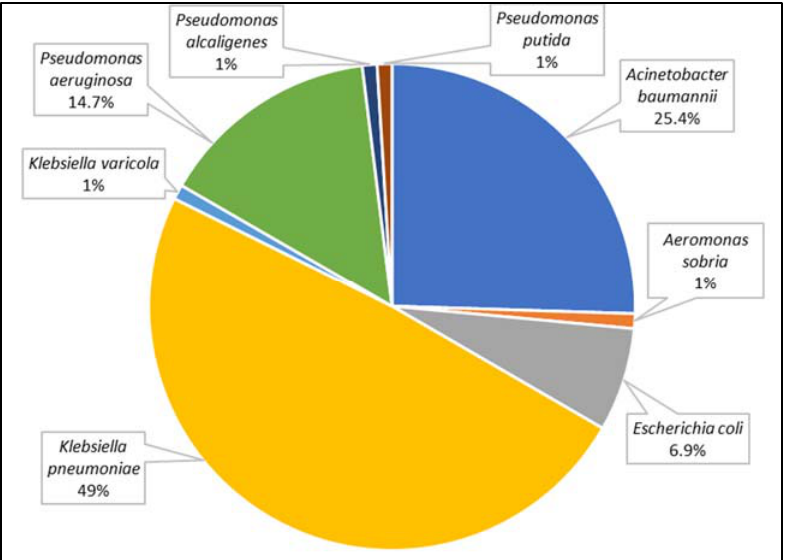
Figure 3. The percentage of carbapenemase-producing species identified from patients hospitalized in Lodz (Poland) taken under consideration in this study.